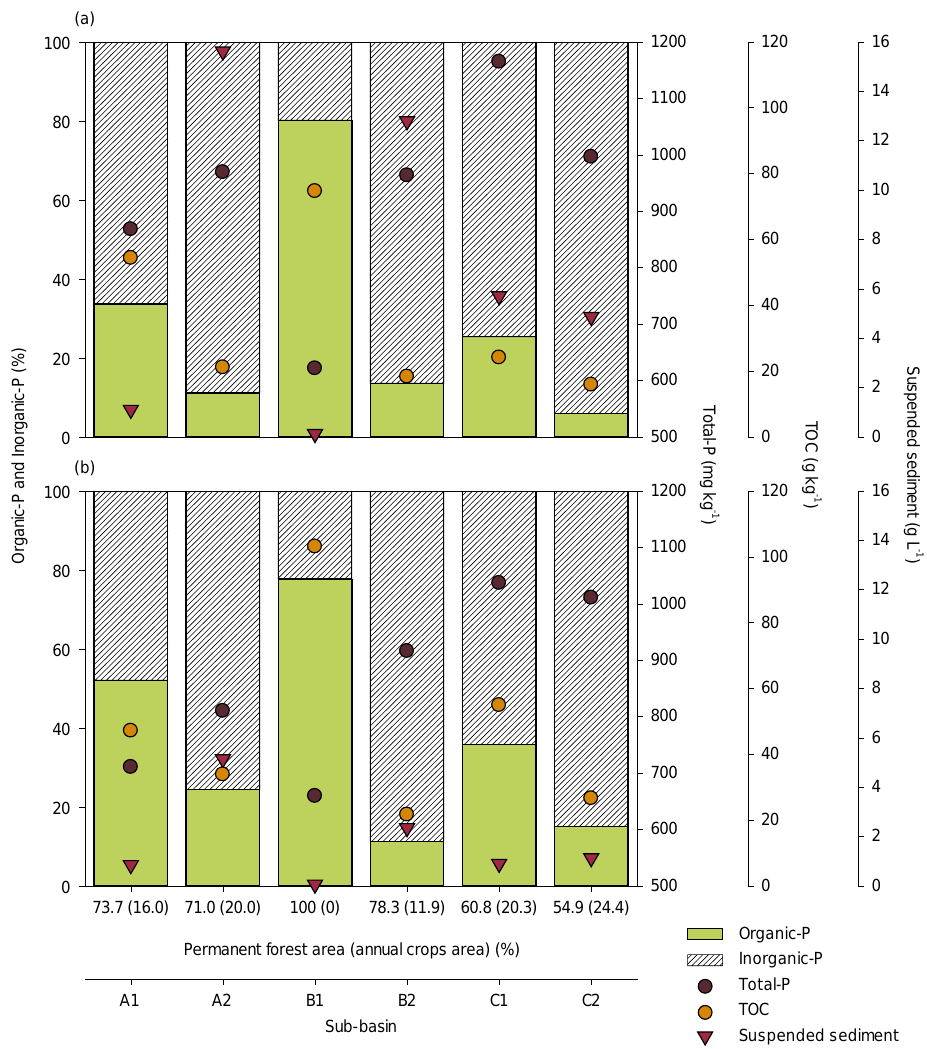
Figure 3. Suspended sediment concentration, total phosphorus content (Total-P), total organic carbon (TOC), and proportion of organic (Organic-P) and inorganic (Inorganic-P) P in relation to the total P content upstream and downstream the Sub-basins A, B, and C, in the storm event occurred in fallow (a) and tobacco transplantation period (b) in Agudo catchment, Rio Grande do Sul,